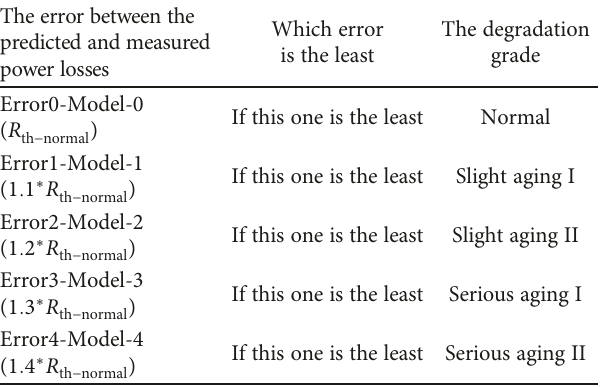
Table 4: The evaluation criteria for condition.